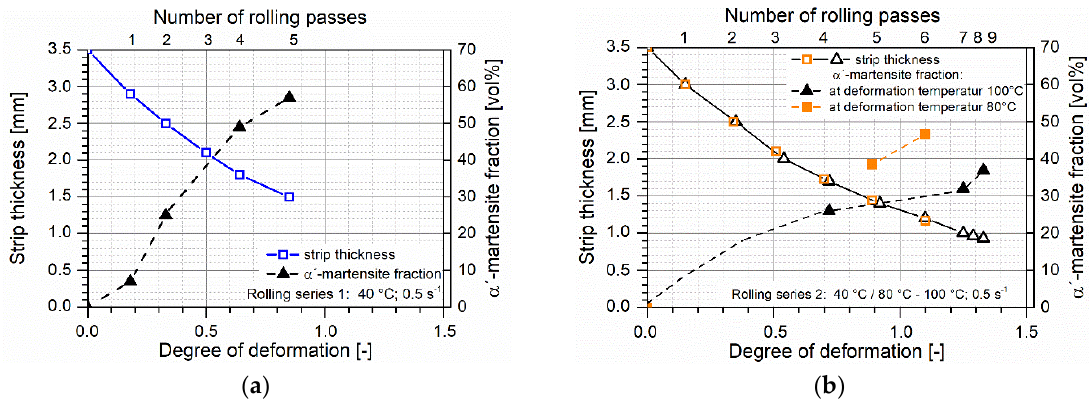
Figure 3. Strip thickness and deformation-induced α´ martensite fraction as a function of the degree of deformation or the number of roll passes of two cold rolling series; ( a ) Series 1: Rolling start temperature of 40 °C for all roll passes, ( b ) Series 2: Rolling start temperature of 40 °C in the initial roll pass and 80−100 °C in the further forming steps.